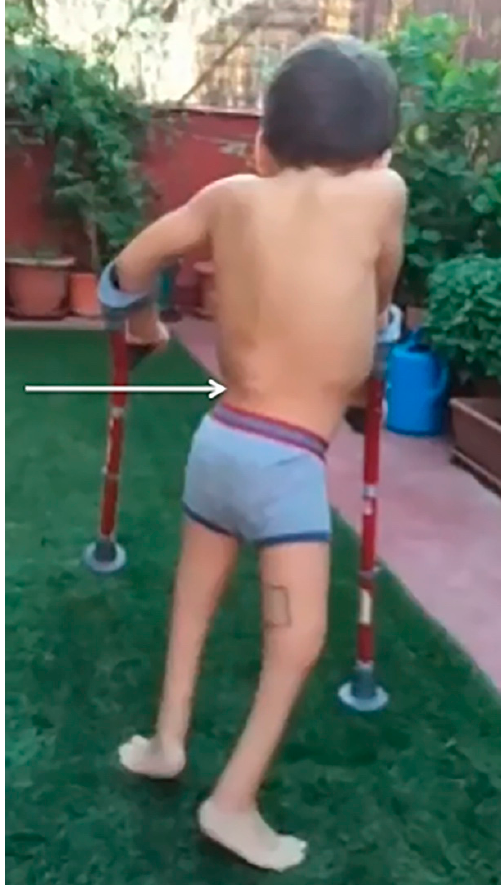
Figure 2. The patient is walking with the help of canes.